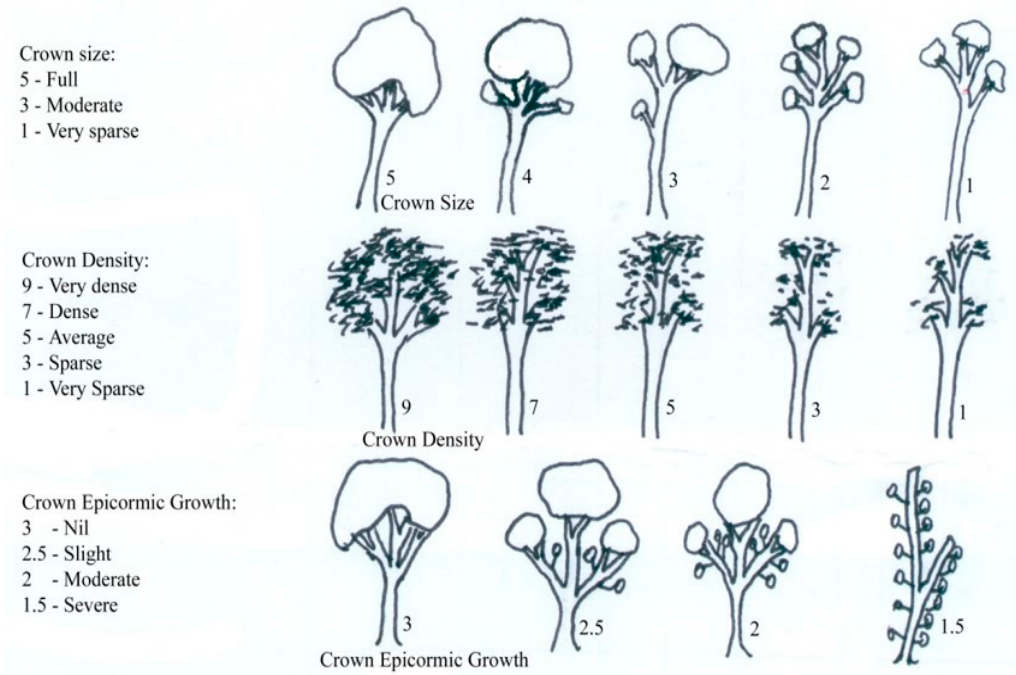
Figure 1. Diagrammatic representation of the urban tree visual vitality index for plantation eucalypts used in this study from Callow et al. [39]. Reproduced with permission from the authors.